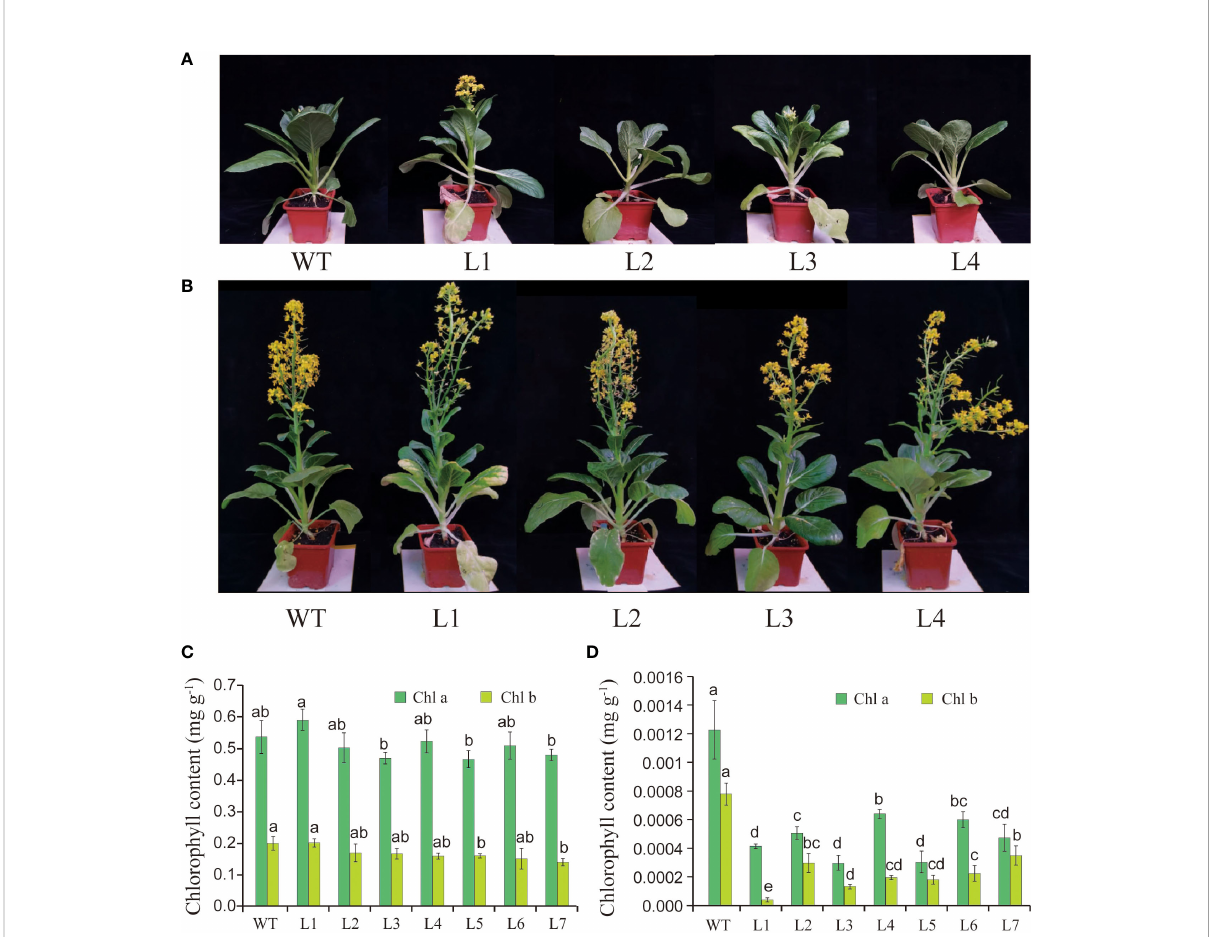
FIGURE 4 (A, B) Effect of BcGRP23 knockdown on the phenotypes of fl owering Chinese cabbage at the initial fl owering stage (A) and the full-bloom stage (B) . Transgenic lines carrying the empty pTRV2 vector (EV) were used as wild type (WT). L1 – L4 represent pTRV2: BcGRP23 . (C, D)